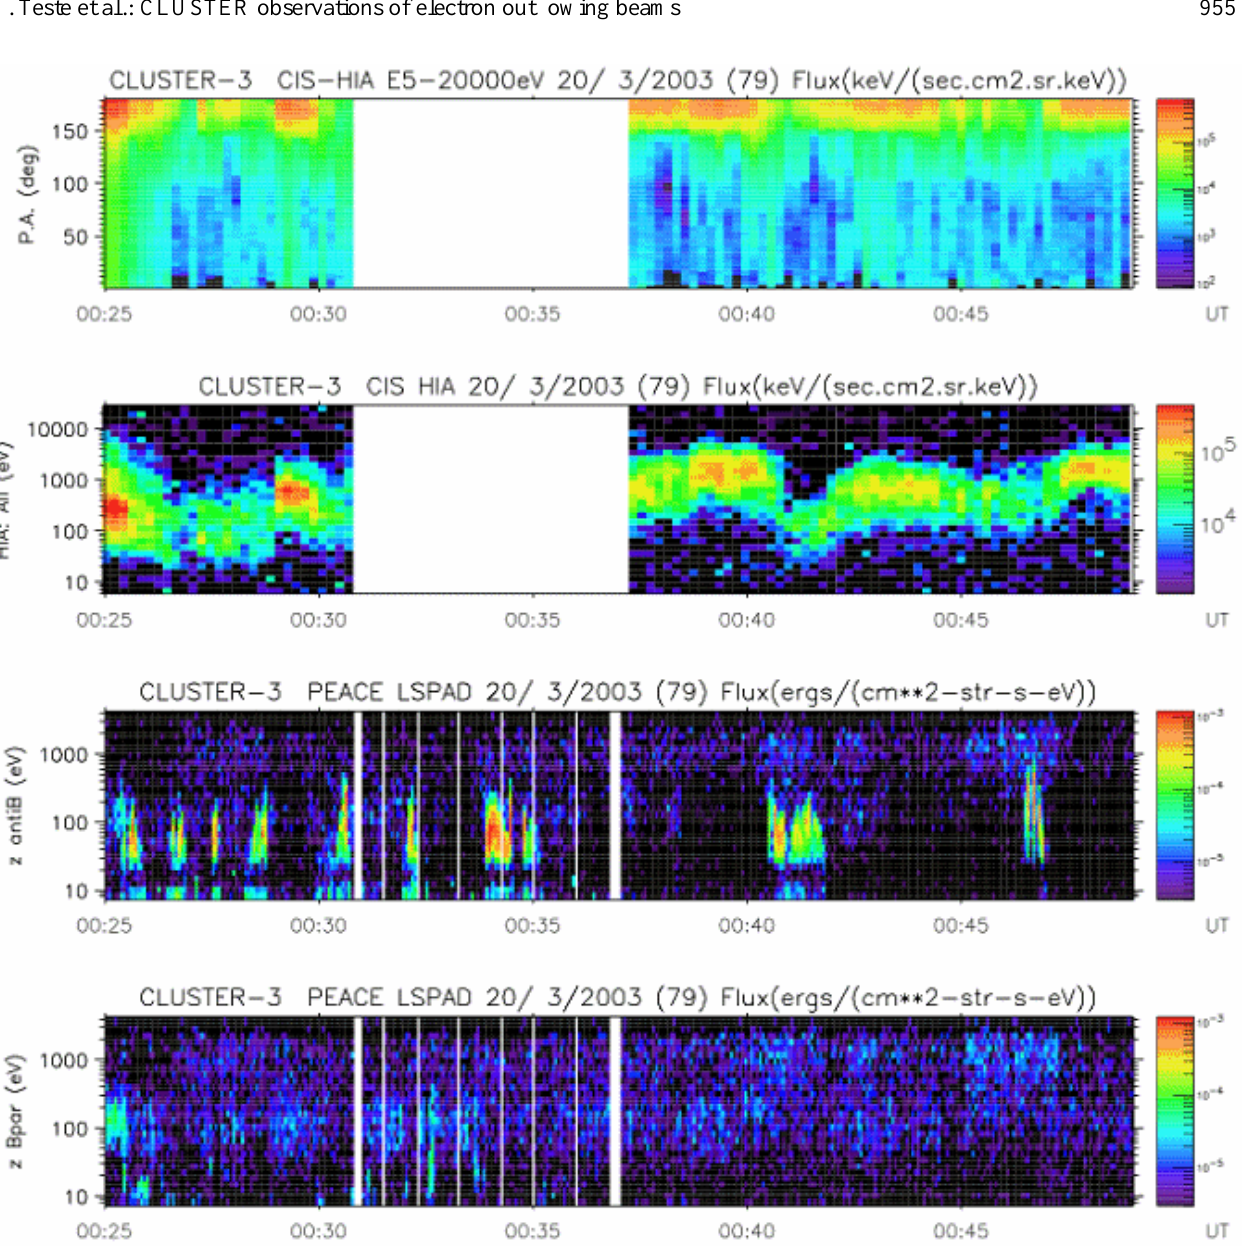
Fig. 1. First two panels: pitch angle and energy distributions of the ion energy fluxes observed by CLUSTER/CIS for 20 March 2003, 00:25–00:50 UT. Last two panels: energy distribution of the electron energy fluxes observed by CLUSTER/PEACE for the same time period in the upward (antiB) and downward (Bpar) directions along the magnetic field